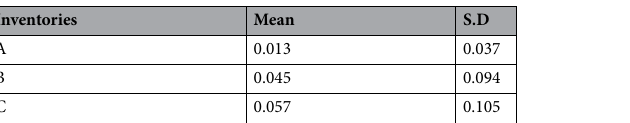
Table 5. General statistics of landslide susceptibility values, described in Sect. 3, for the LSMs from the three larger inventories considered in this work ( cf. Figure 3); S.D stands for standard